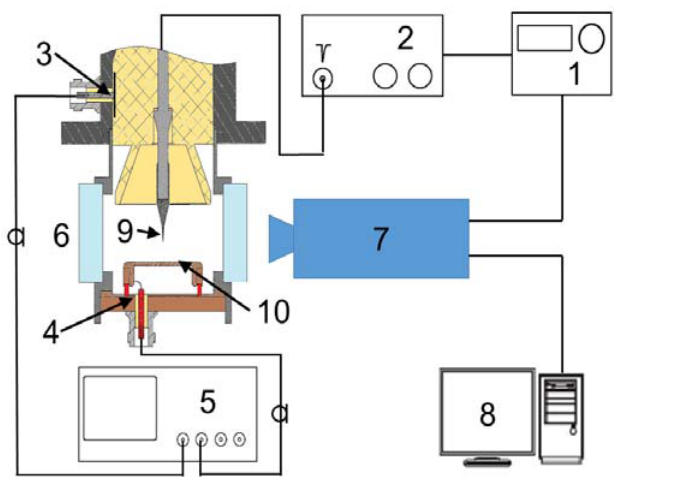
Figure 1 – The experimental setup: 1 – triggering pulse generator, 2 – pulsed voltage source, 3 – capacitive voltage divider, 4 – current shunt resistor, 5 – storage oscilloscope, 6 – output window, 7 – ICCD camera, 8 – personal computer, 9 – metal tip